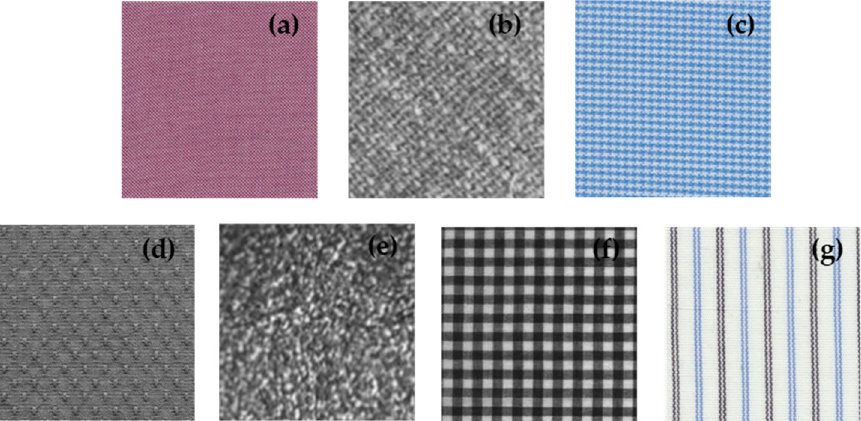
Figure 2. Various textures of fabric images. ( a ) Plain fabric, ( b ) twill fabric, ( c ) star-patterned fabric, ( d ) dot-patterned fabric, ( e ) statistical-texture fabrics, ( f ) box-patterned fabric, and ( g ) striped